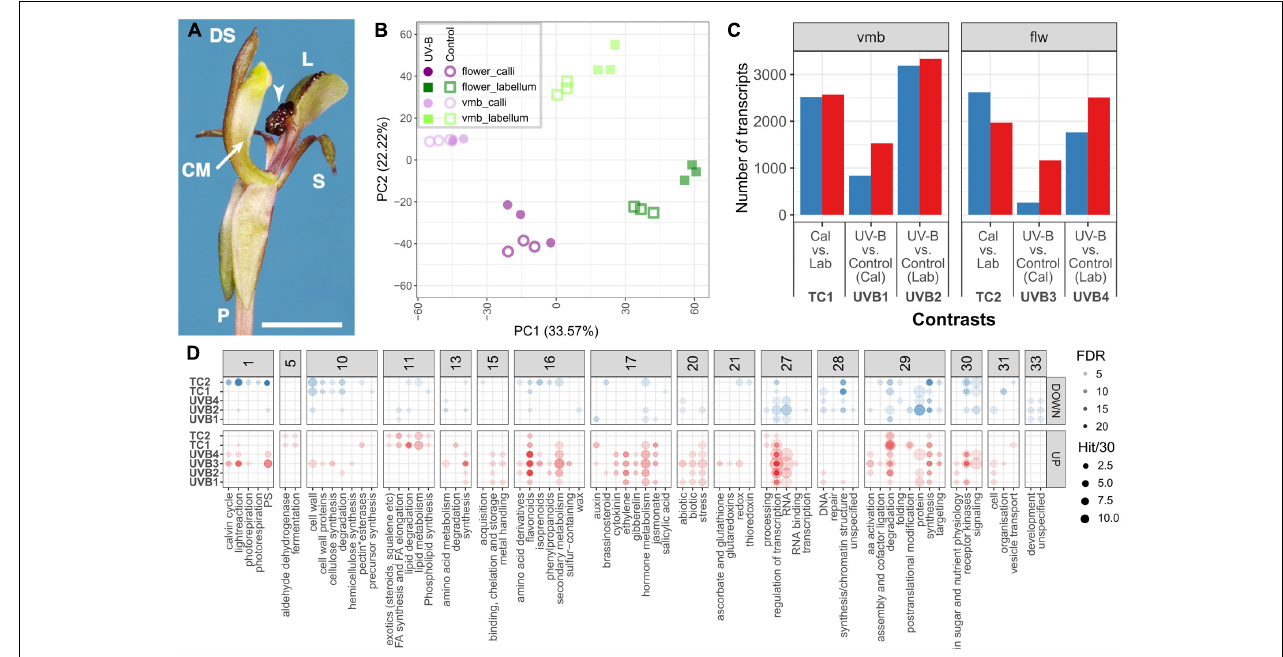
FIGURE 2 | Analysis of C. trapeziformis expressed transcriptome. (A) The floral structure of C. trapeziformis consists of the callus (arrows), column (CM), dorsal sepal (DS), labellum (L), petals (P), and lateral sepals (S). Scale bar = 7 mm. (B) Principal component analysis of the transcriptome across 24 samples representing eight different tissue/treatment types. Dark purple, light purple, dark green, and light green depict callus tissues of flowers (flw), callus tissues of very mature buds (vmbs), labellum tissues of flw, and labellum tissues of vmbs, respectively. Filled circles/squares depict 2 h UV-B treated samples. Empty circles/squares depict control (covered) samples. (C) Summary of differentially expressed transcripts in vmb (TC1, UVB1, UVB2) and flower (TC2, UVB3, UVB4) developmental stages. The number of upregulated and downregulated in each comparison are shown. (D) Summary of enriched high-level (BIN depth ≤ 2) MapMan BIN categories (FDR < 0.05) describing general plant biological processes and functions for tissue and UV-B treatment comparisons in (C) . Red and blue colors depict enrichments for upregulated and downregulated groups of each contrast. The opacity of each circle depicts enrichments (FDR) for each enriched category. The size of the circles depicts the number of transcripts in each enriched category (See Figure for more details on opacity and size assignments). Further details can be found in Supplementary Data 3 – 5